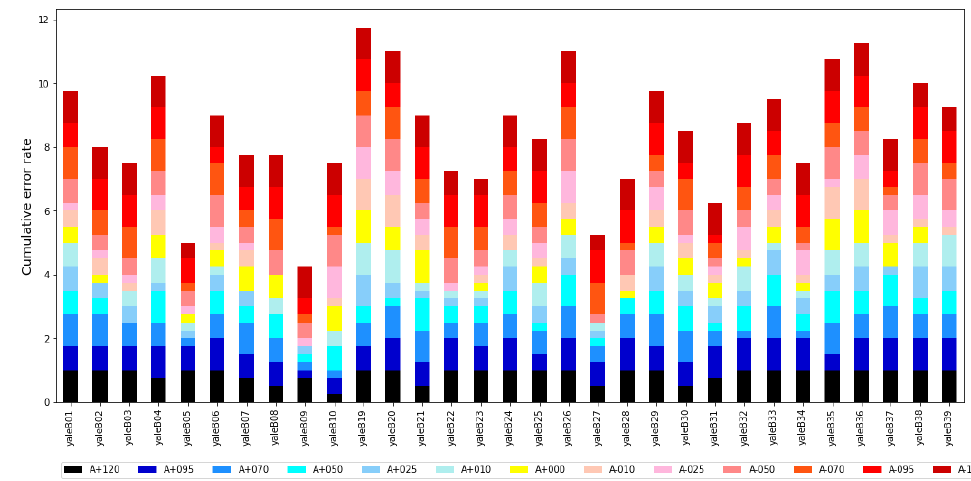
Figure 11. Comparison of error rate of OpenFace with different ambient light levels.